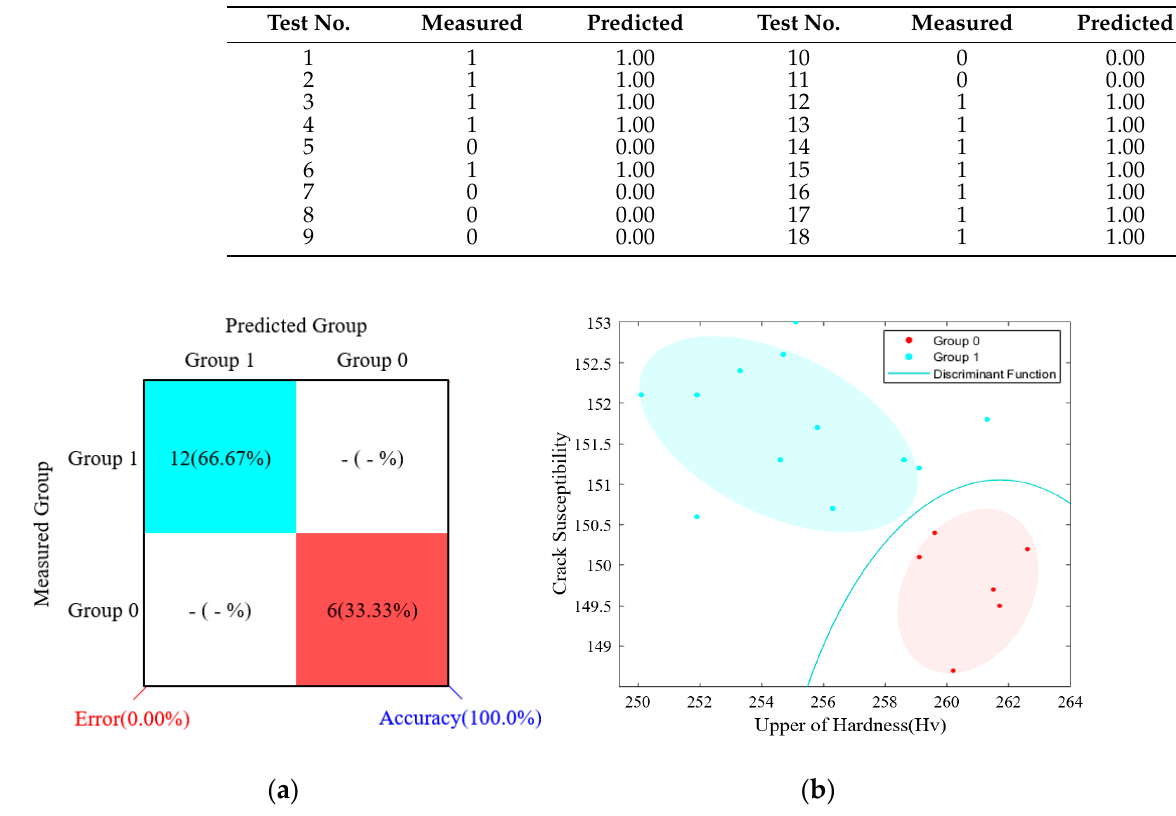
Table 10. Comparison of the measured results and predicted results with the Support Vector Machine (SVM) technique.